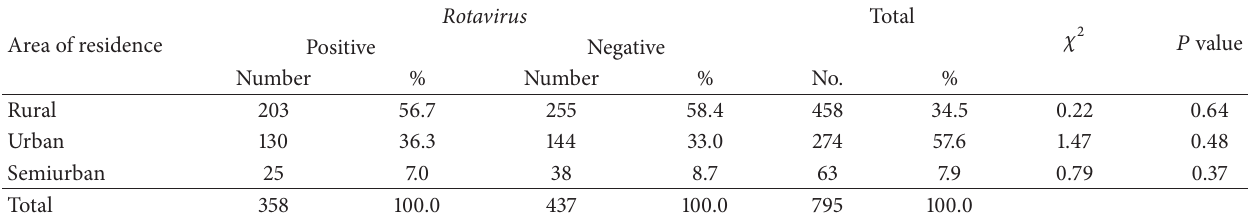
Table 8: Distribution of Rotavirus diarrhea among children according to the area of residence in Taiz, Yemen (𝑛 = 795) .